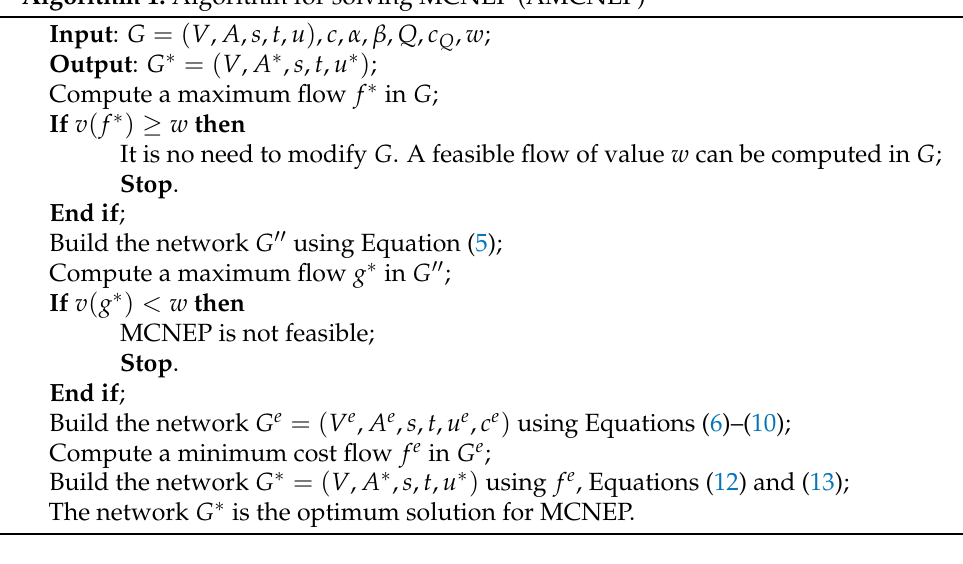
Algorithm 1: Algorithm for solving MCNEP